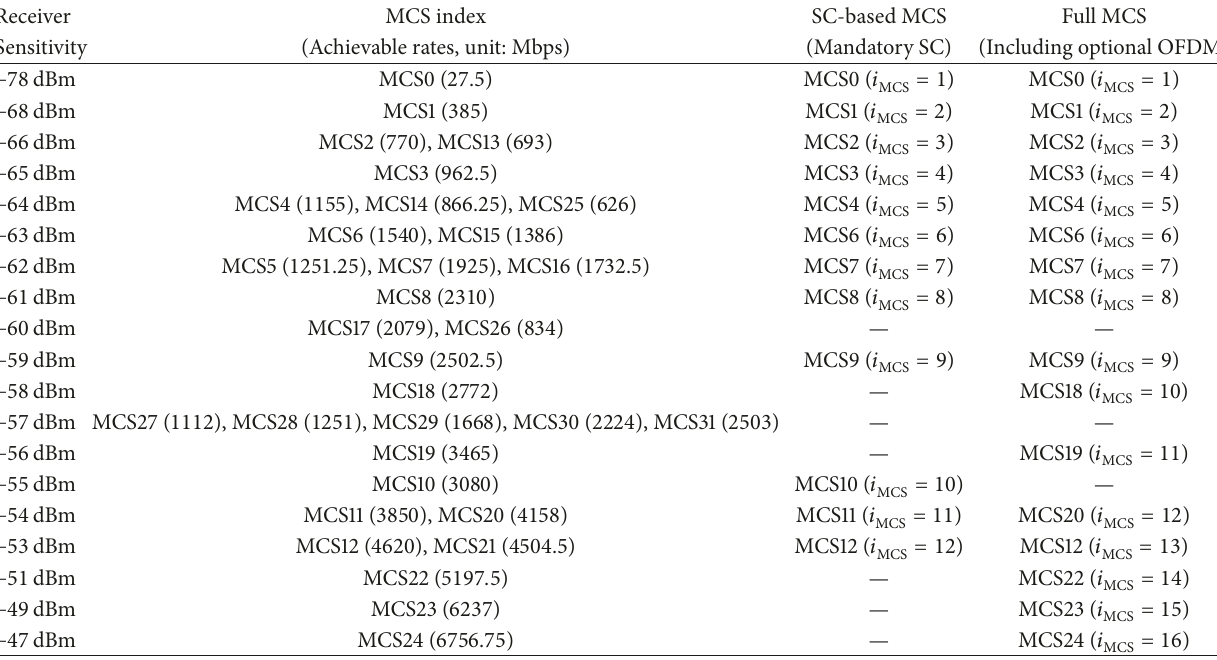
Table 1: WiGig/IEEE 802.11ad MCS Index Table (regenerated from Table 21-3 in WiGig/IEEE 802.11ad [10]), assuming that (i) 5dB implementation loss, (ii) 10dB noise factor (Noise Figure), and (iii) packet error rate (PER) shall be less than 1% when the payload length is 4000 bytes.